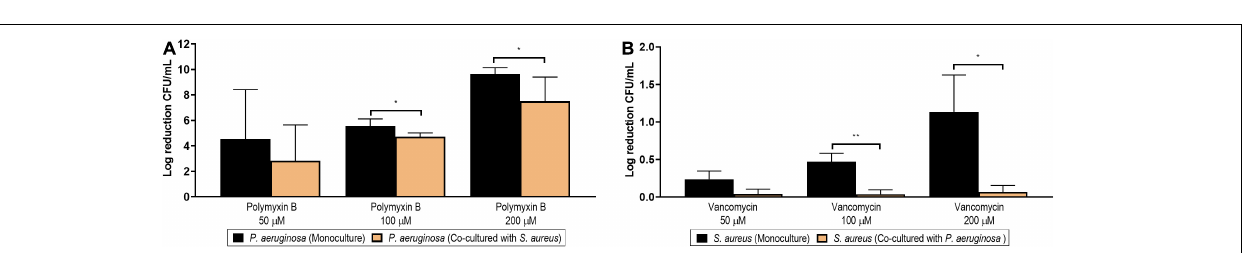
FIGURE 13 | Log reduction of the viable counts (colony-forming unit/ml) of Pseudomonas aeruginosa PAO1 (A) and Staphylococcus aureus (B) biofilms after the treatment with different concentrations of polymyxin B (50, 100, and 200 µ M) and vancomycin (50, 100, and 200 µ M), respectively. The black columns represent the log reduction achieved in monoculture conditions, while the orange columns represent the log reduction in co-culture conditions. The results are expressed as the mean of three or more biological repetitions with their SD (Student’s t -test; * p < 0.05 and ** p <